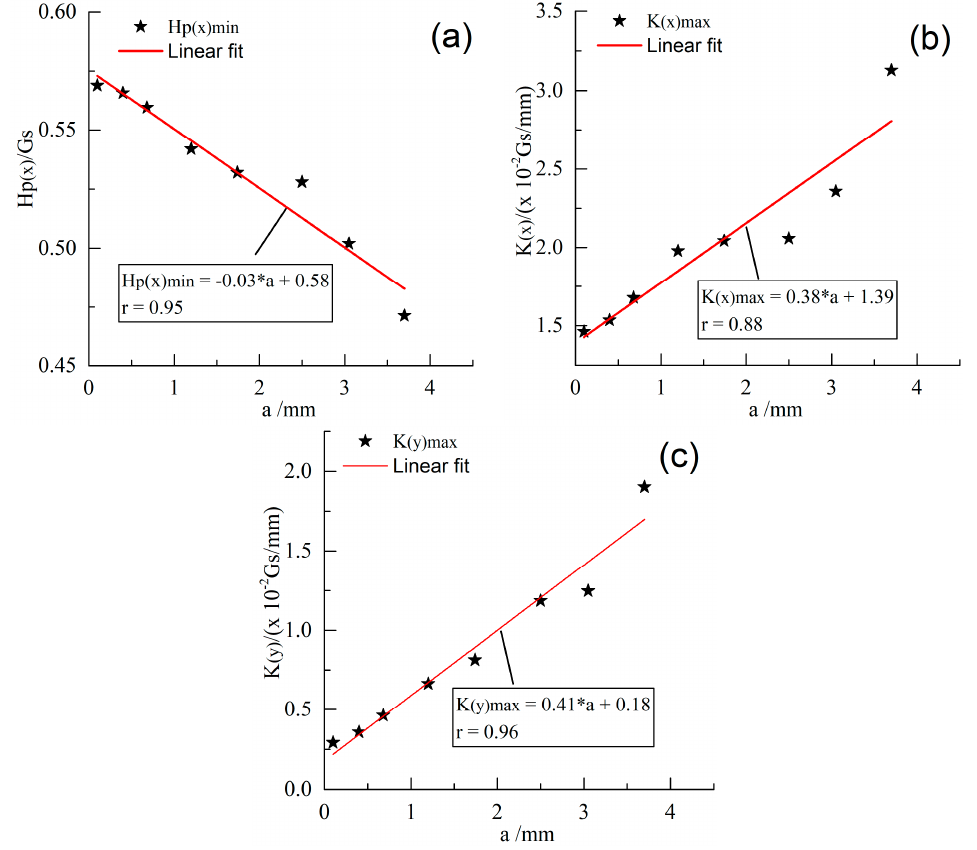
Figure 16. The relationship between the characteristics and the length of the crack propagation after linear fitting: ( a ) H p (x) min ; ( b ) K(x) max ; and ( c ) K(y) max .